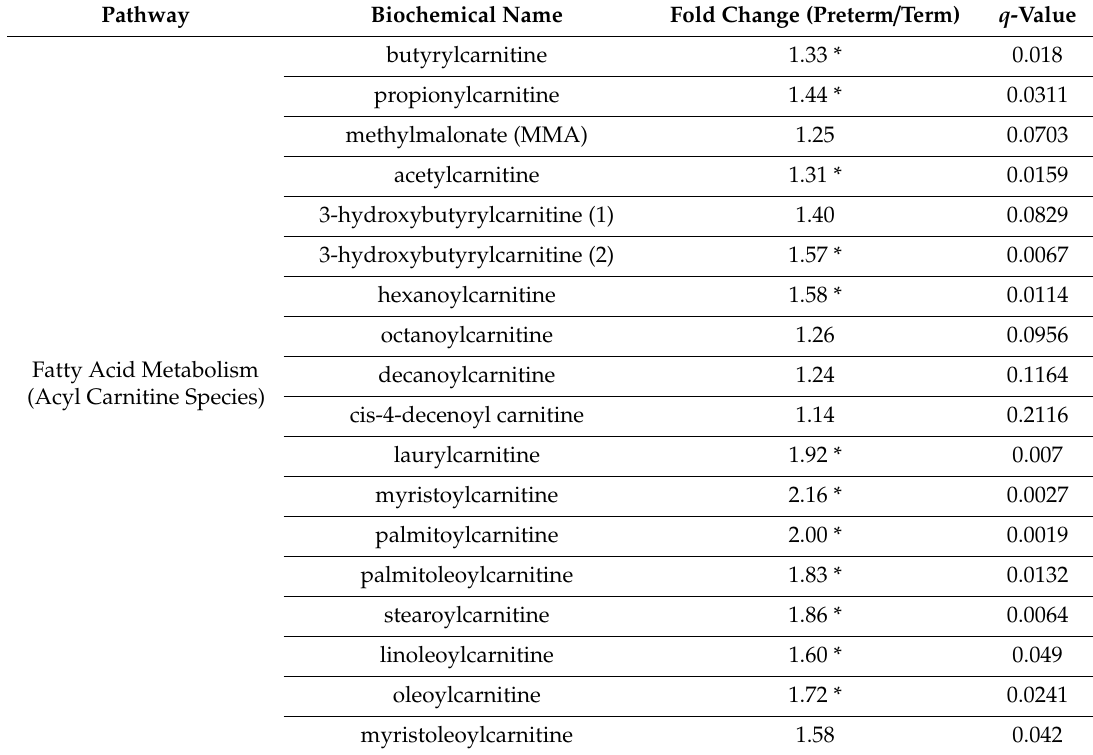
Table 6. Fold change in acylcarnitines in placenta.